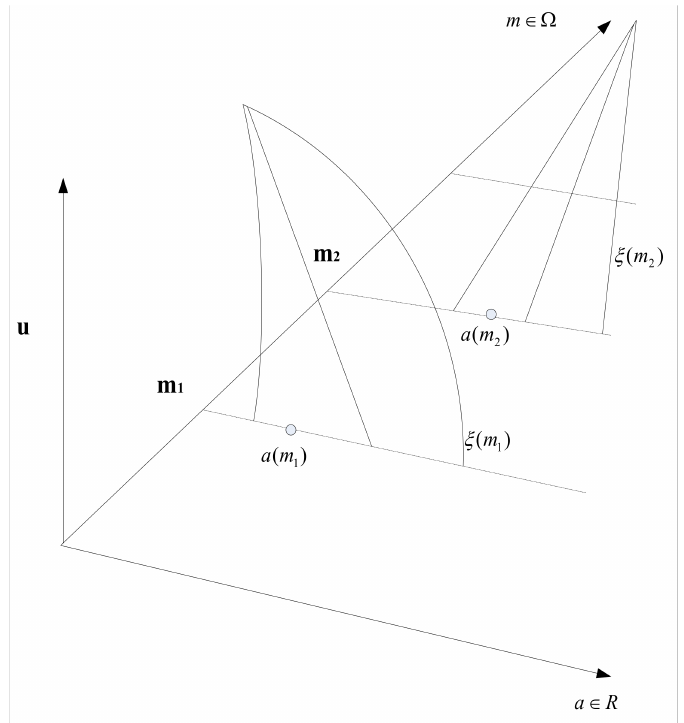
Figure 4. Typical fuzzy random variable